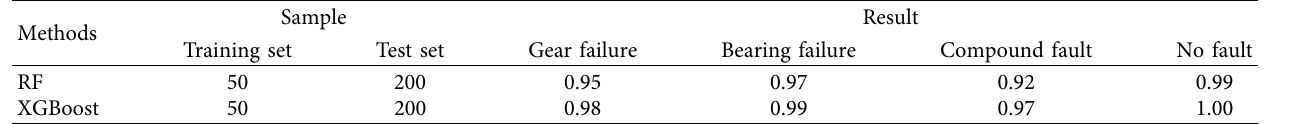
Table 2: XGBoost and RF classification of FE-MVMD